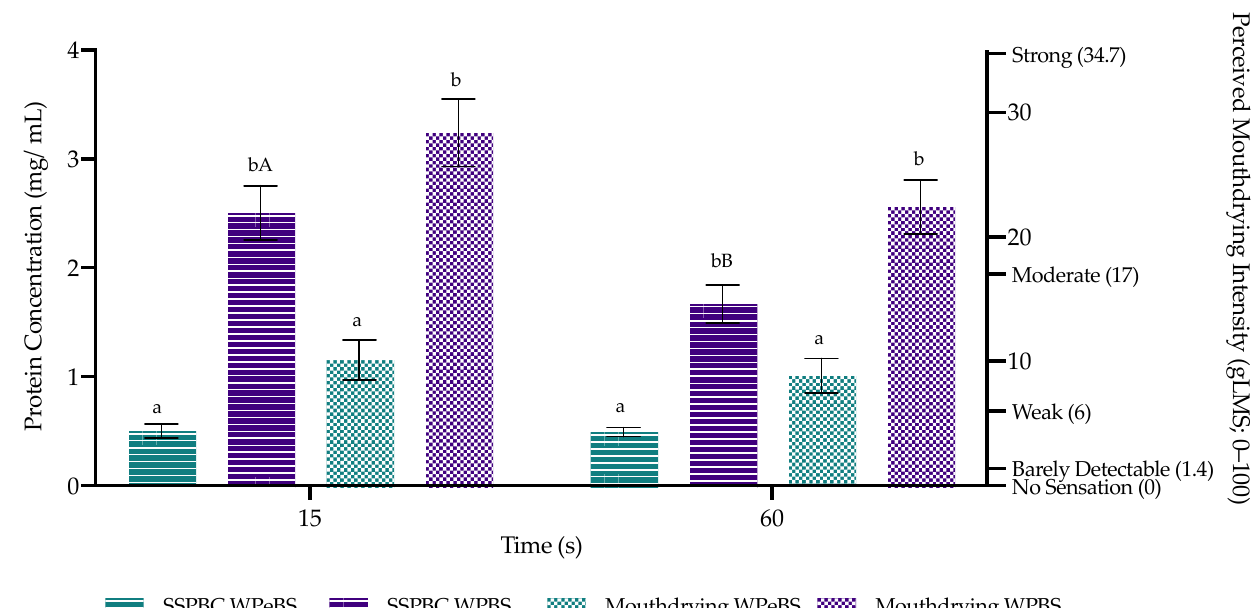
Figure 7. Protein concentration in saliva samples post beverage consumption (SSPBC) (left axis) and perceived mouthdrying (right axis; measured on gLMS (0–100)) (±standard error). WPeBS: whey permeate beverage sweetened and WPBS: whey protein beverage sweetened. Sample significant differences are represented by differing small letters (between samples) and capital letters (within samples).